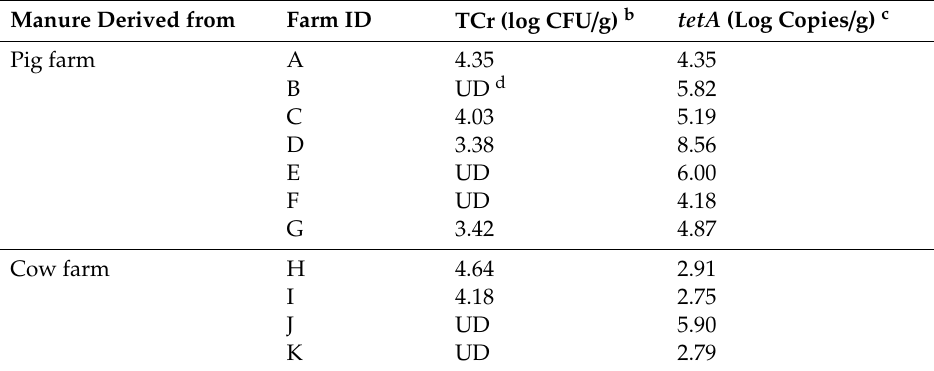
Table 1. The prevalence and concentrations of TCr a) and tetA in livestock manure Manure Derived from